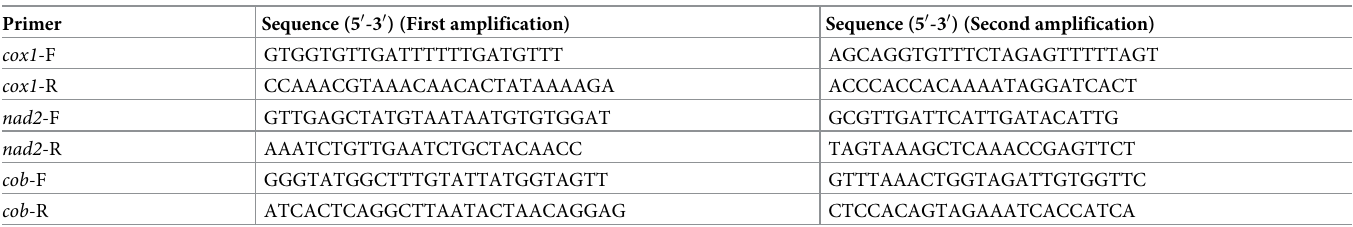
Table 1. Primers designed for amplification of the partial sequences of E . multilocularis cox1 , nad2 and cob genes using nested PCR. Primer